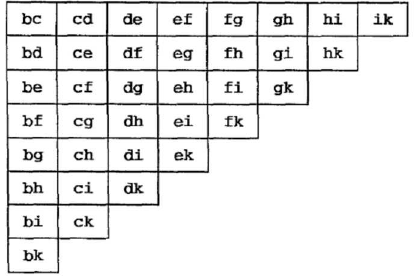
Figure 7. Based on (McLean,